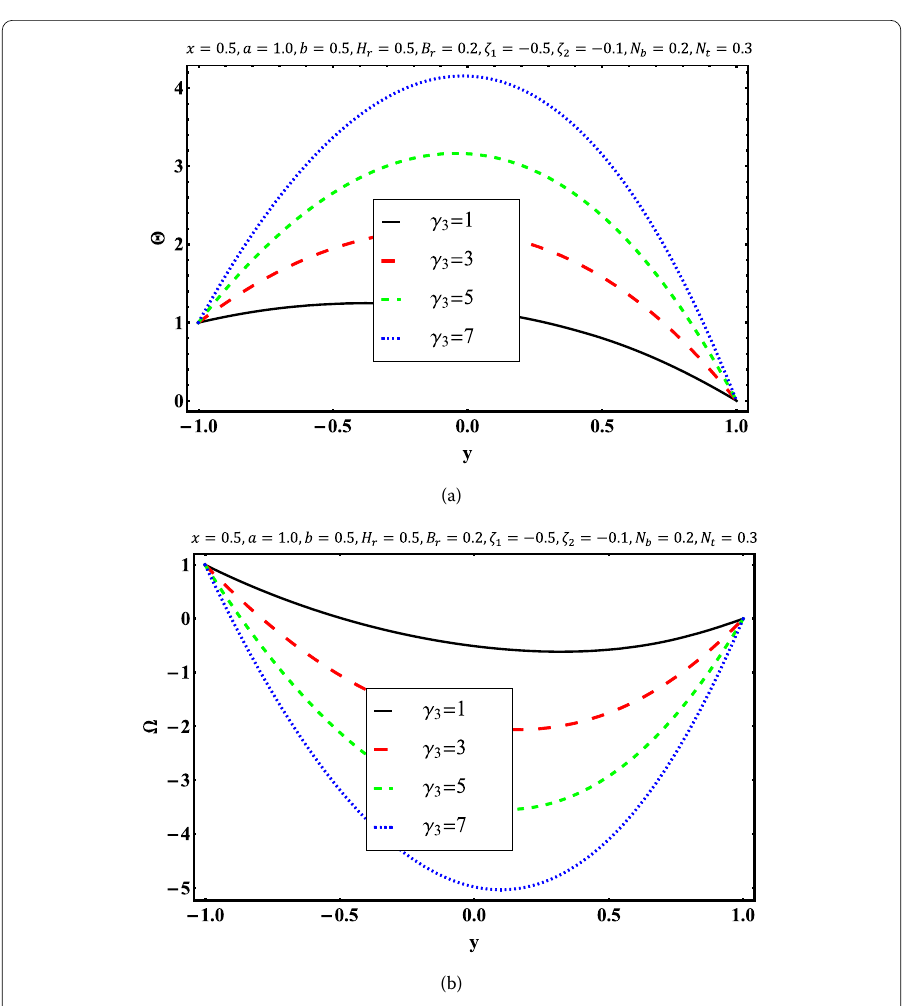
Figure 9 For different values of γ 3 ( a ), temperature distribution Θ ( b ) and concentration distribution Ω